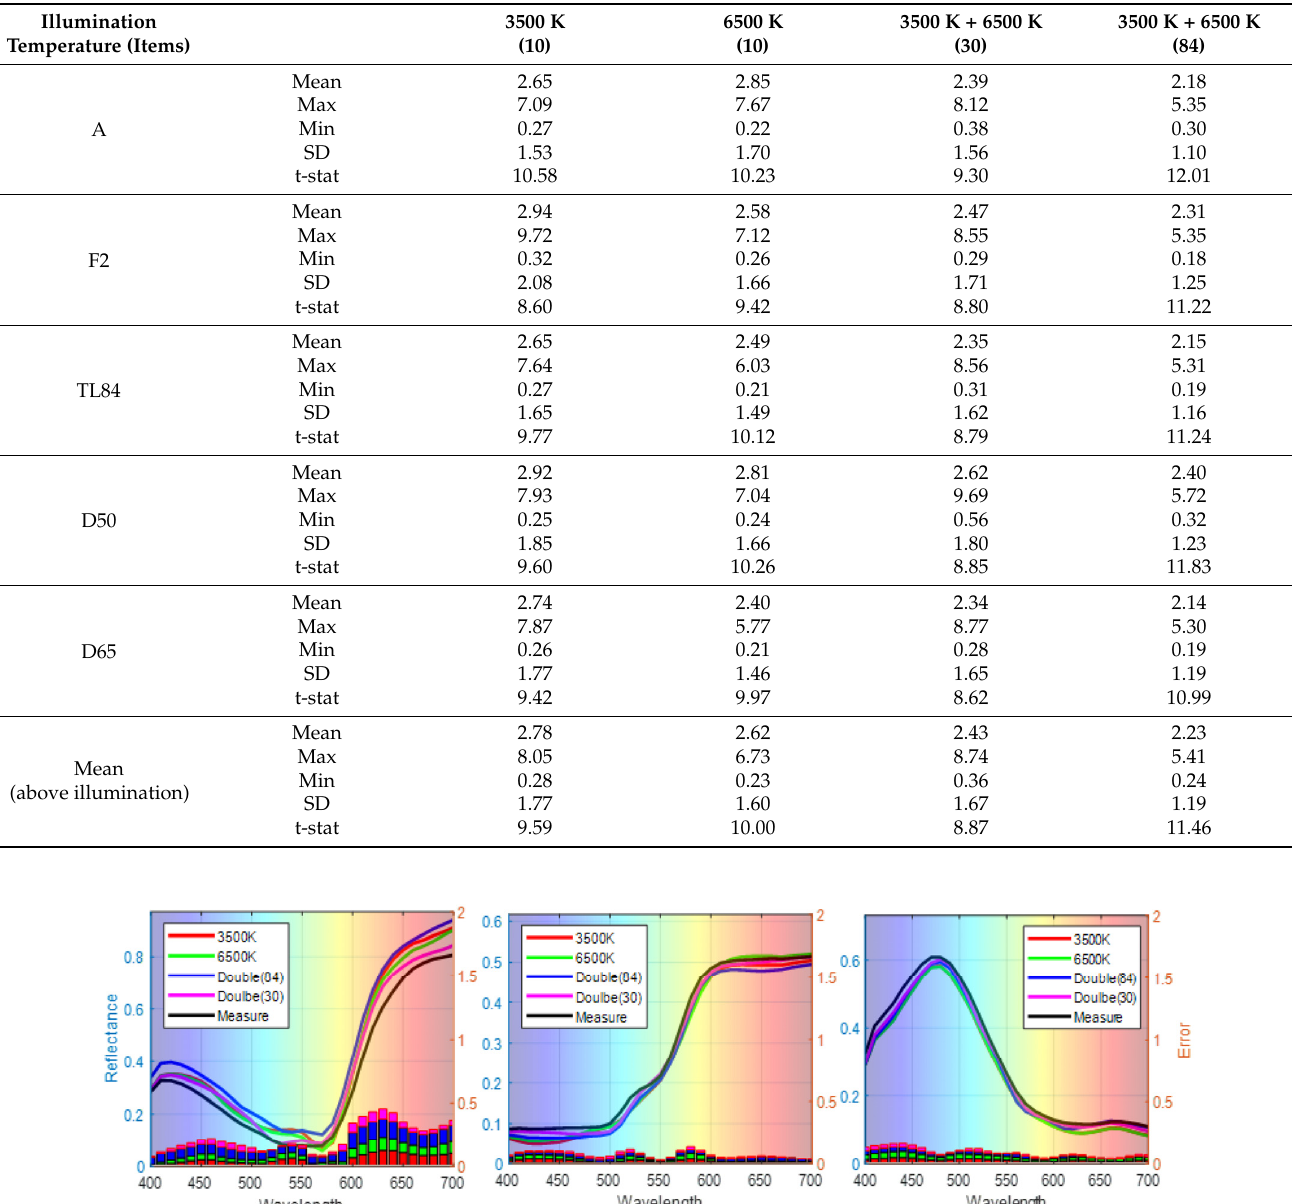
Table 5. Metamerism performance of four methods under different illuminations.